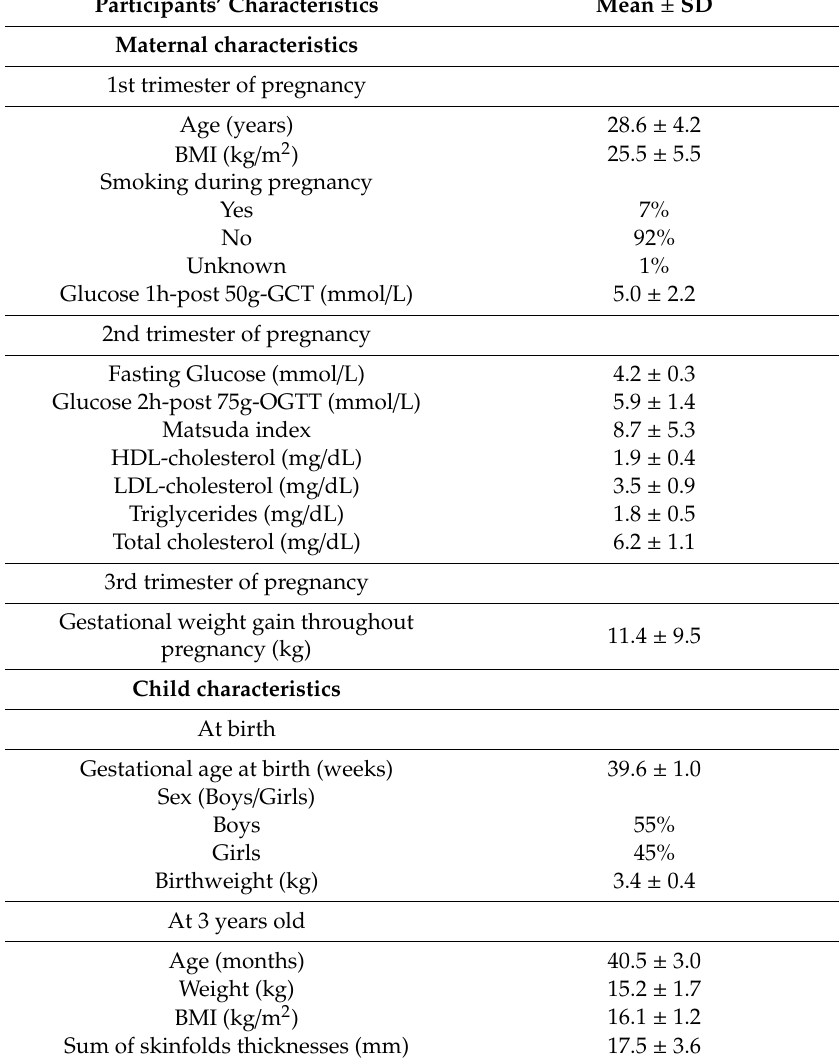
Table 1. Characteristics of the mothers and children from Gen3G prospective cohort included in the